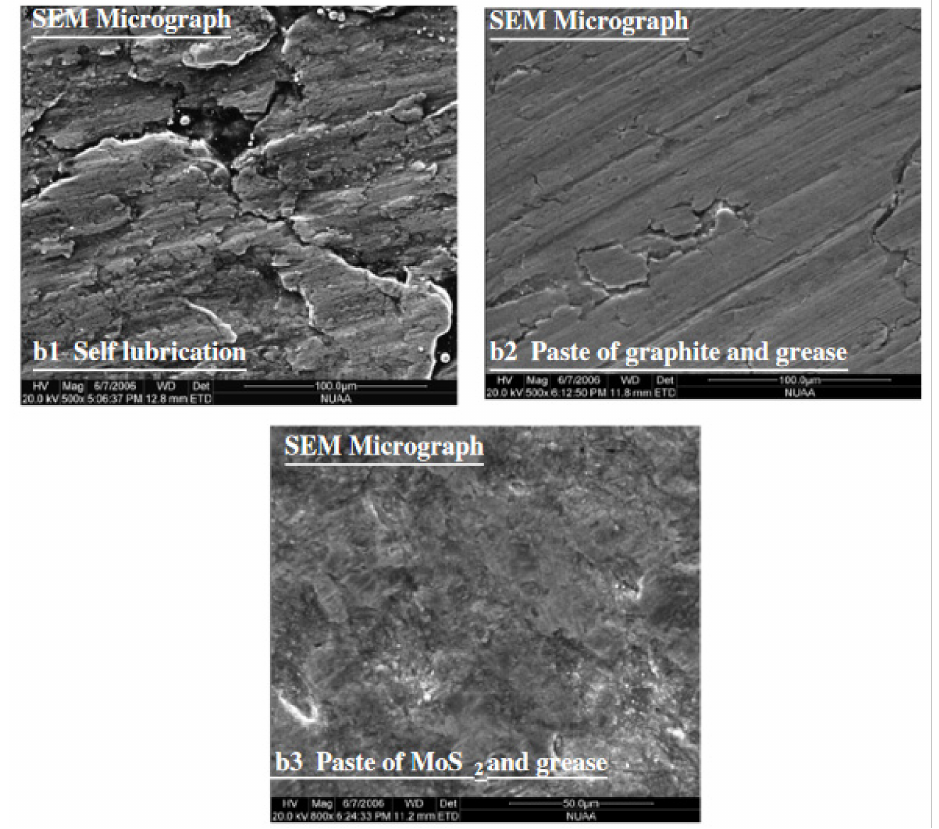
Figure 27. The effect of friction conditions on the surface quality of truncate cone drawpieces formed from pure titanium (reprinted with permission from [154]; copyright © 2007, Springer-Verlag London